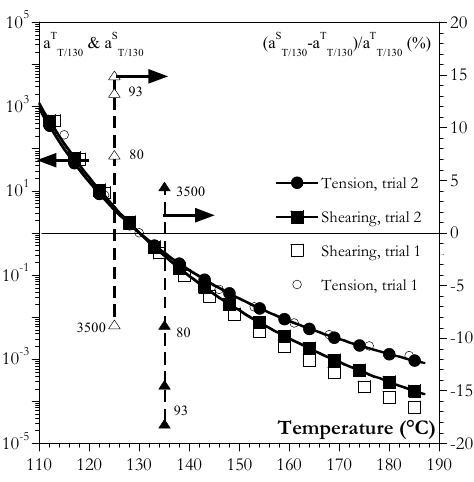
Figure 5. Comparison between a S and, a T (scale on the left side) for PMMA 93 using two sets of trials (plain and hollow squares and circles). Triangles (scale on the right side) depict the relative differences in shift factors between the tension and torsion in % for two arbitrary temperatures (resp. T ref − 5 ◦ C and T ref + 5 ◦ C ) and for all PMMA (figures refer to their identifiers). Curves were recalculated from parameters given in Table